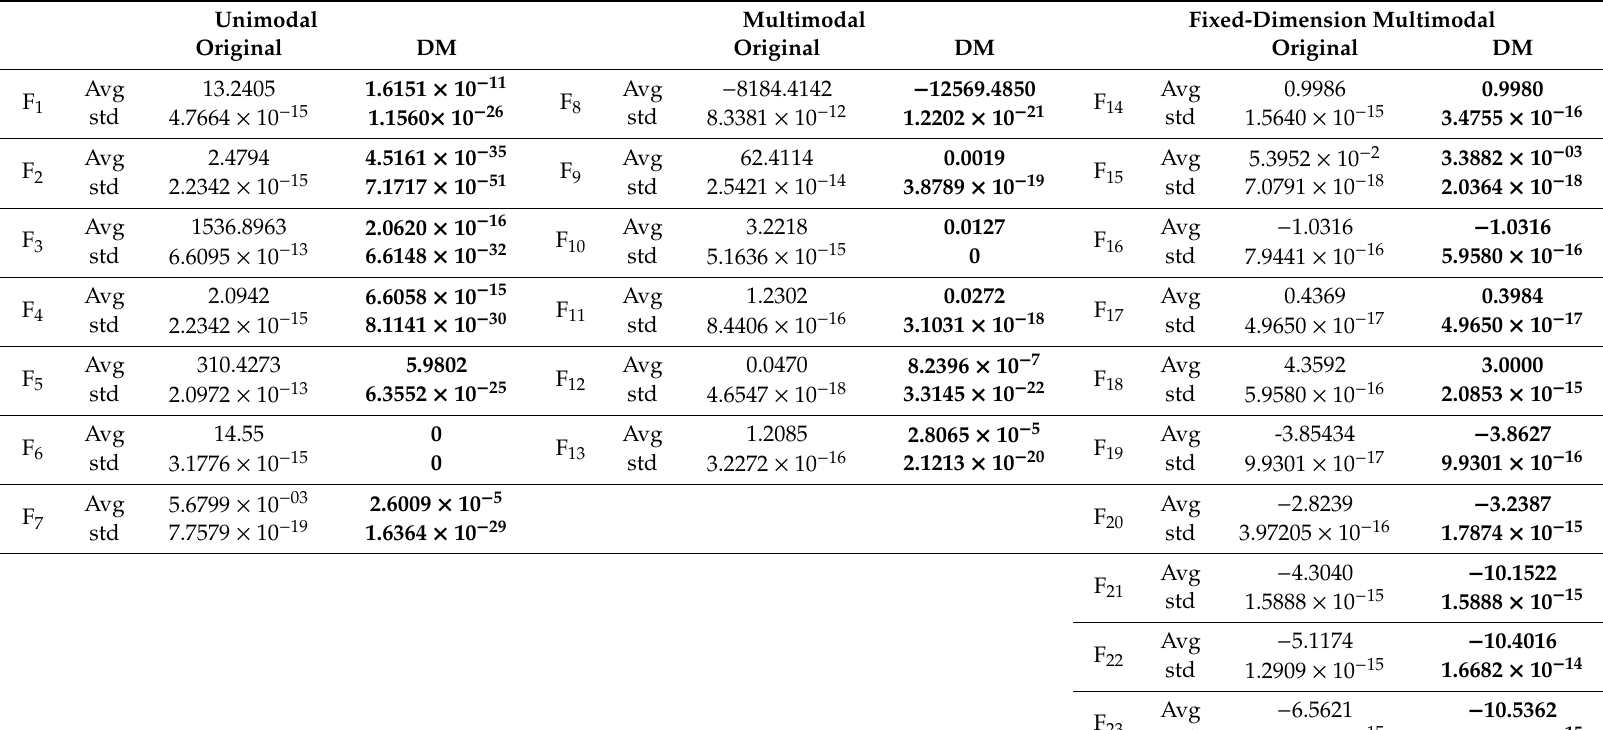
Table 2. Optimization results of genetic algorithm (GA) for original and “modified by DM”